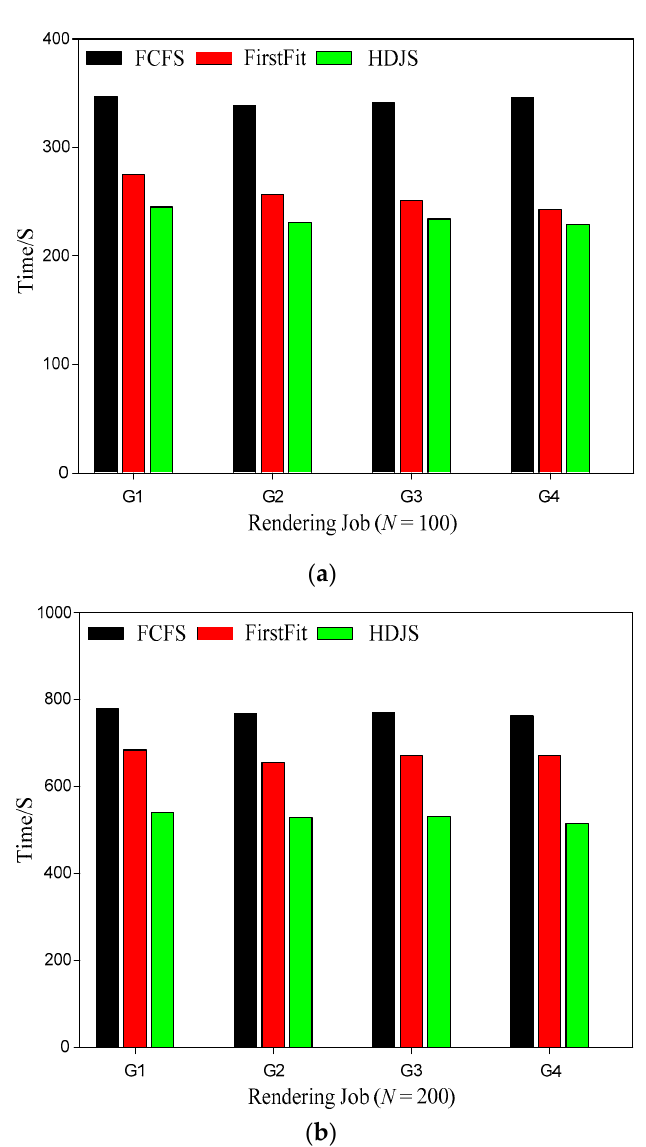
Figure 4. Comparison of average completion time for different strategies; ( a ) N = 100; ( b ) N = 200.